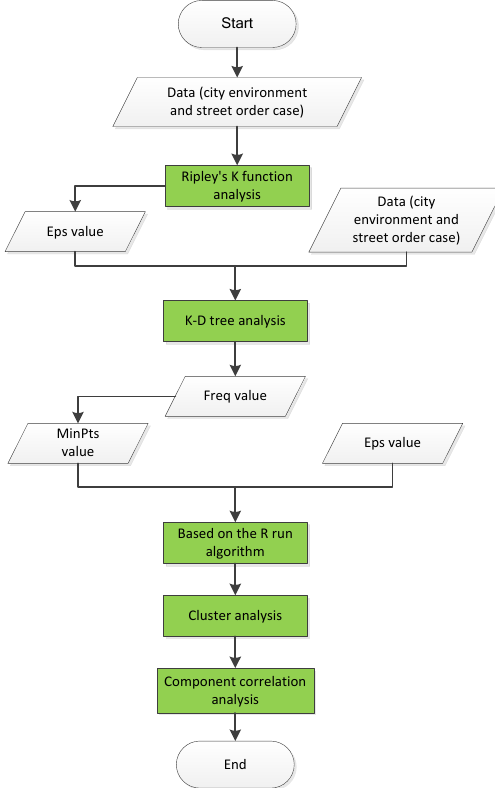
Figure3. Flow chart for the research